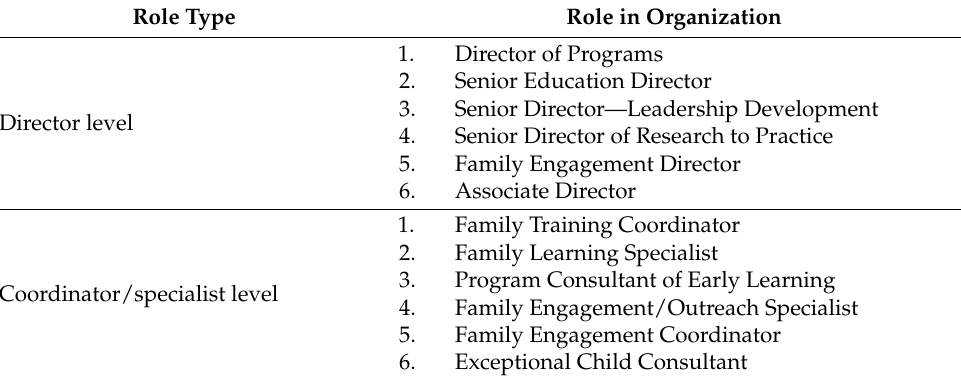
Table 2. Titles of